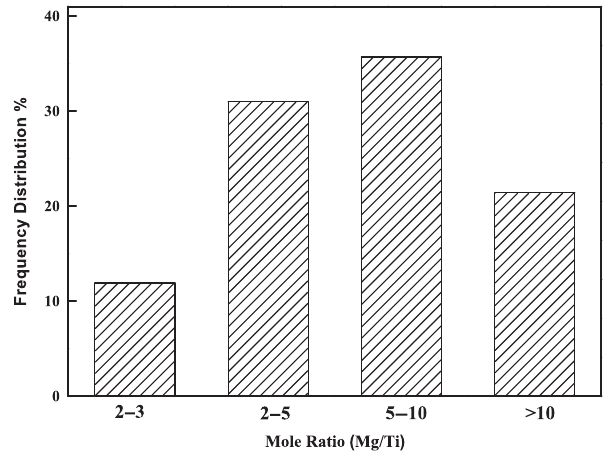
Figure 2: The distribution of mole ratio (Mg/Ti) in margin of Ti-Mg-O inclusions.